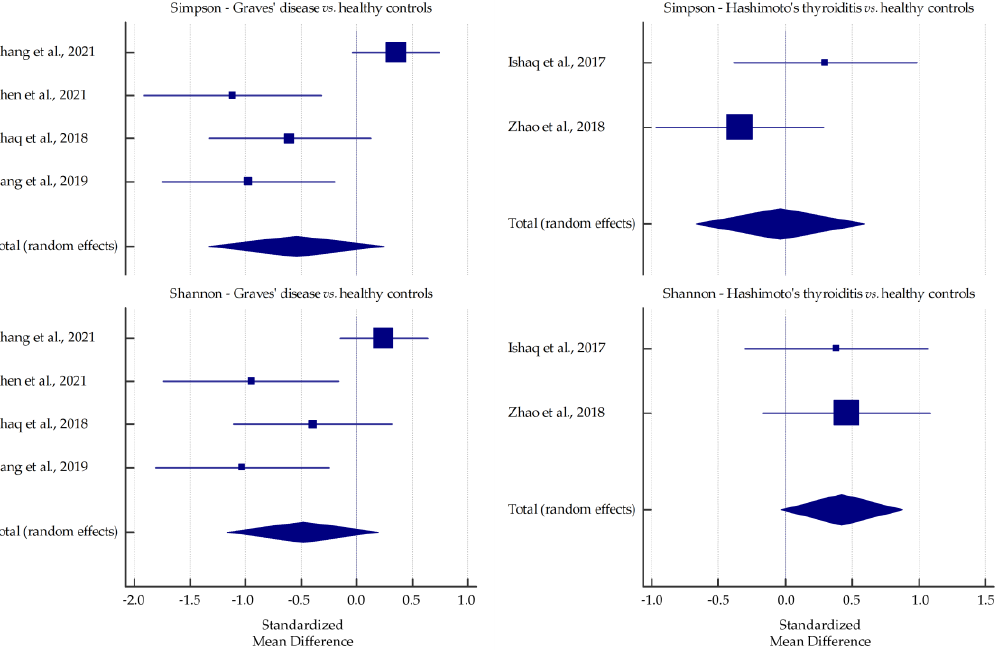
Figure 4. Pooled standardized mean differences in Simpson and Shannon indices, shown separately for Graves’ disease and Hashimoto’s thyroiditis